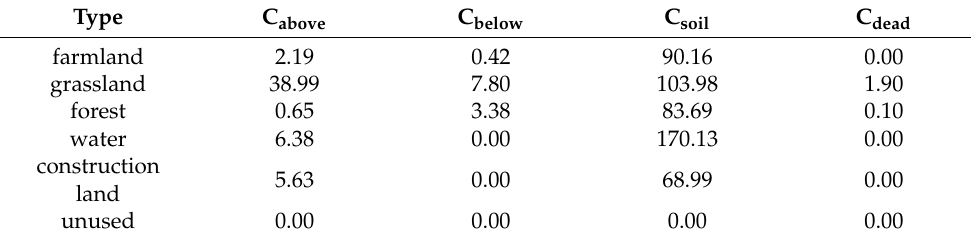
Table 1. Carbon density of various land use types in the Taihang Mountains (t·km − 2 ). Type C above C below C soil C dead farmland 2.19 0.00 grassland forest water construction land unused